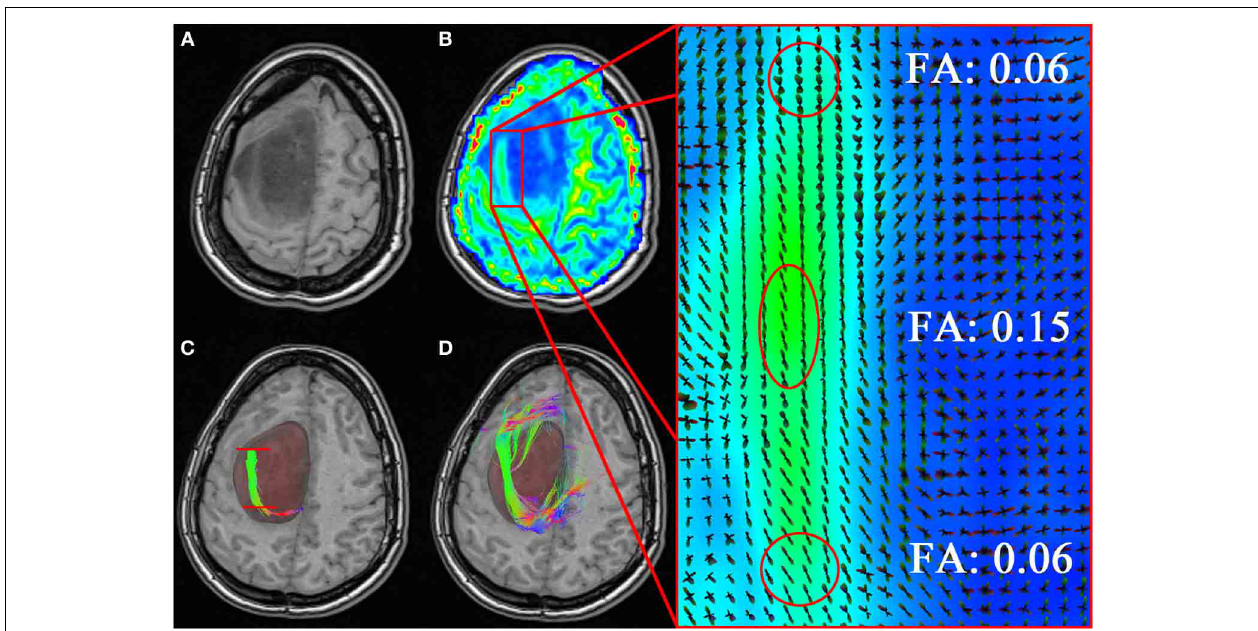
FIGURE 8 | Neurosurgical application of the MultiPeak-RTT method. (A) T1-weighted image revealing an anaplastic astrocytoma tumor extending across the left hemisphere of the brain. (B) Coherent structure within the tumor region in accordance to local orientations (zoomed rectangle). In